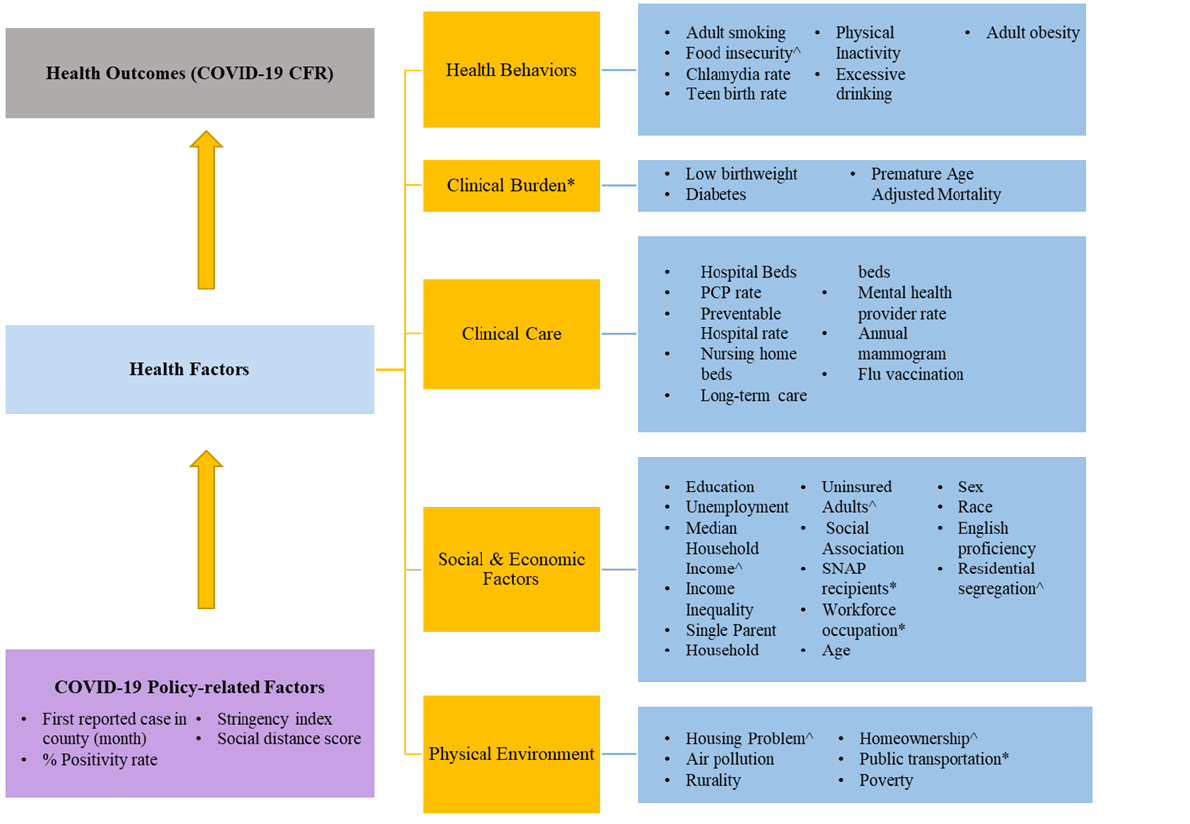
Figure 1: Theoretical Framework Based on the County Health Rankings Model To Establish a Relationship Between COVID-19 Case Fatality Rate and County-level Ecological